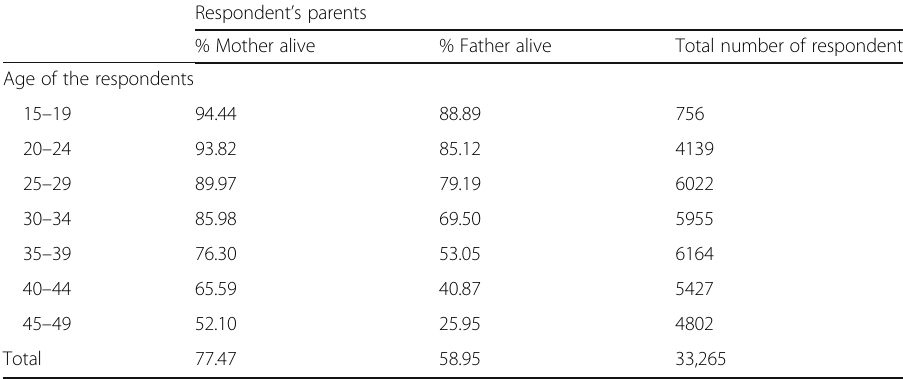
Table 1 Percentage of ever-married women aged 15 – 49 by age with mother/father living, India Human Development Survey 2011 – 2012